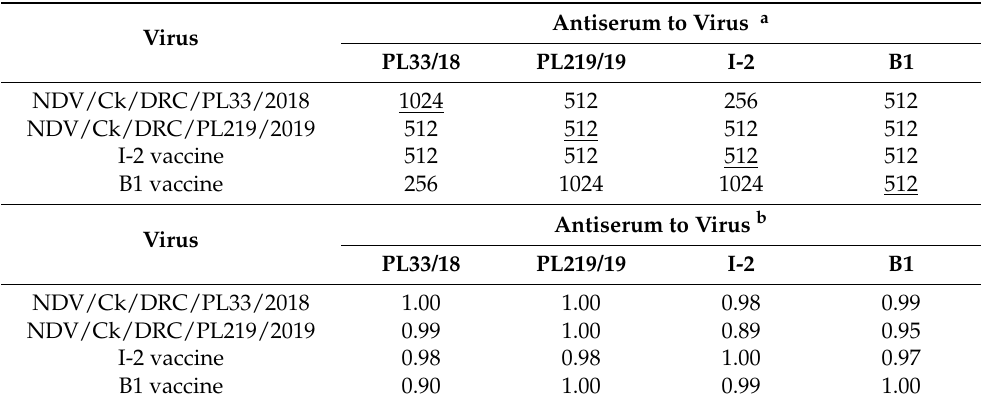
Table 3. The antigenic relatedness between the Congo isolates and vaccine